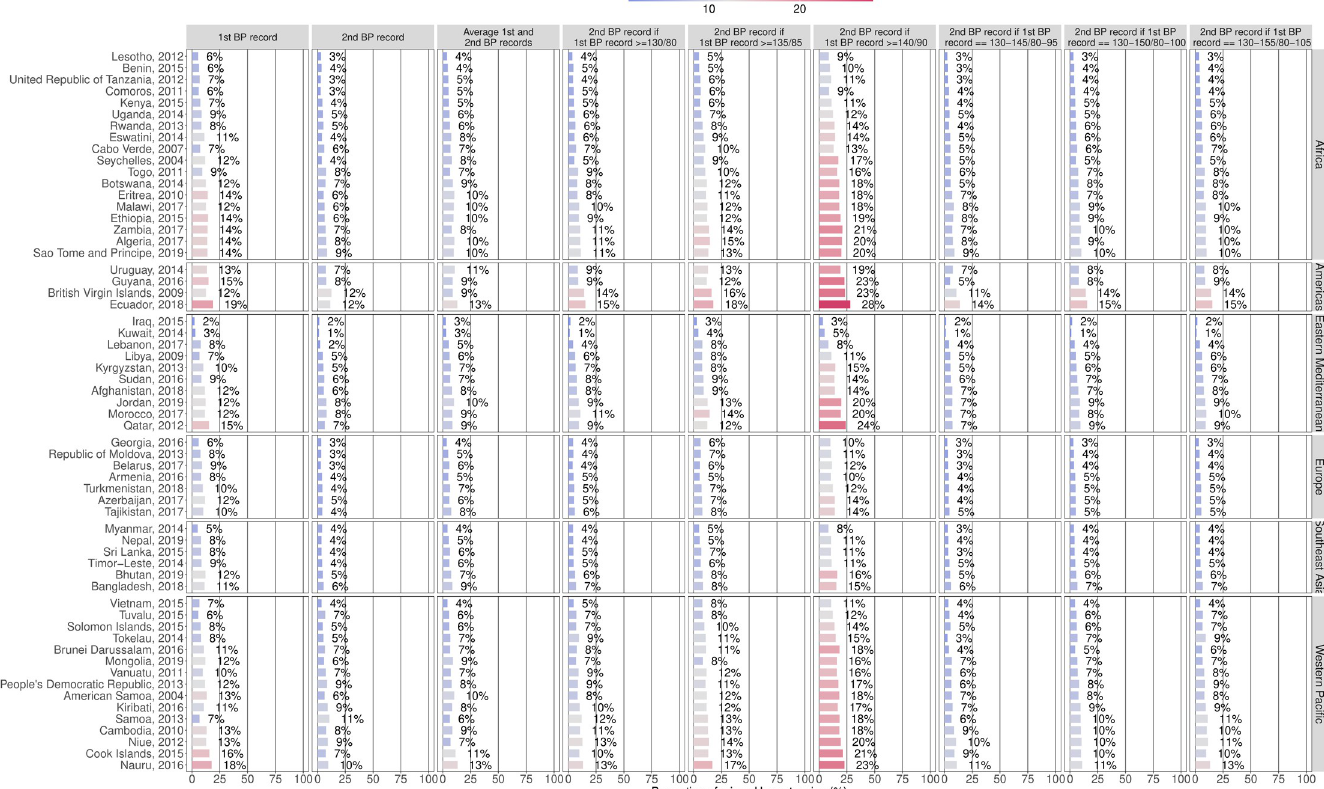
Fig 1. Proportion (%) of missed hypertension cases for the 9 simplified approaches, stratified by country and region. BP values given in millimetres of mercury. BP, blood pressure.